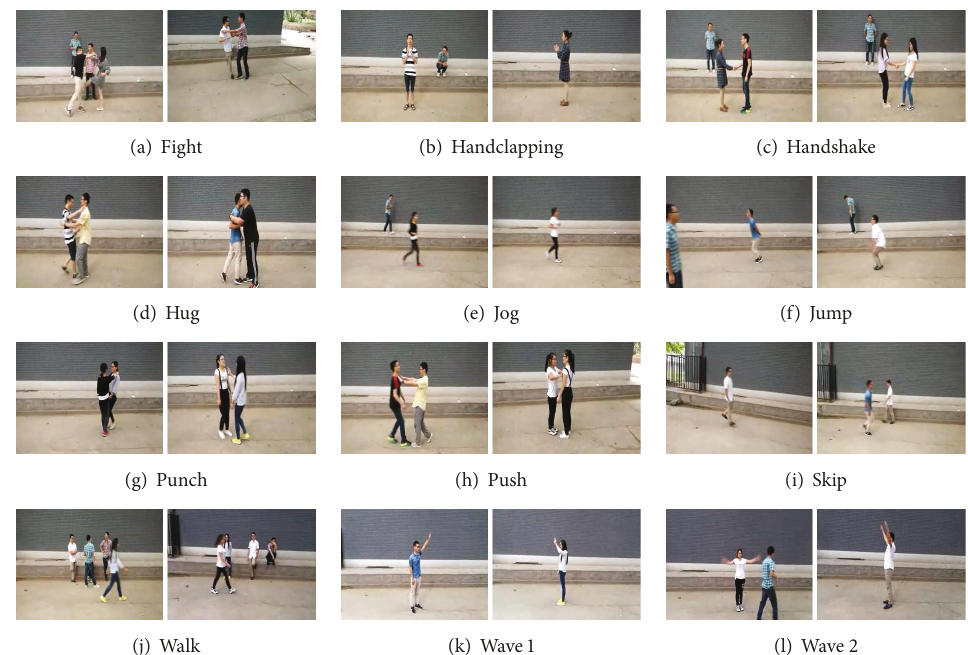
Figure 5: 12 actions of the newly constructed visible light action dataset XD145.